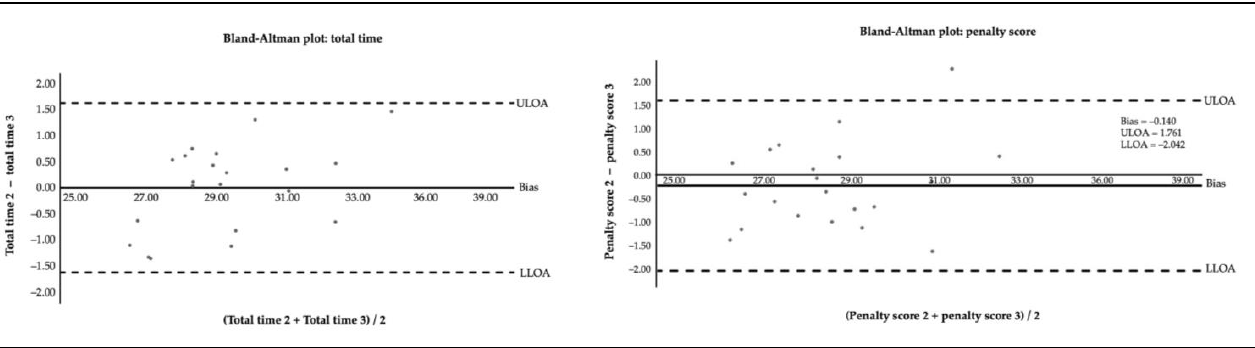
Figure 2. Agreement of repeated measures for the total time and the penalty score. The dashed lines represent 95% limits of agreement (±1.96 SD), lower limits of agreement (LLOA), and upper limits of agreement (ULOA).